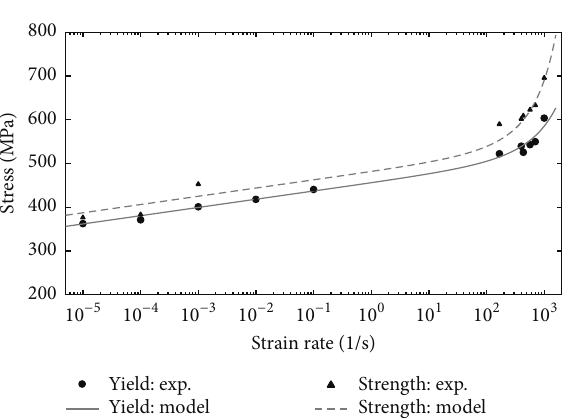
Figure6: Comparisonbetween experimental data (Wang et al. [39]) and new modified Eyring equation for Ti-47Al-2Mn-2Nb